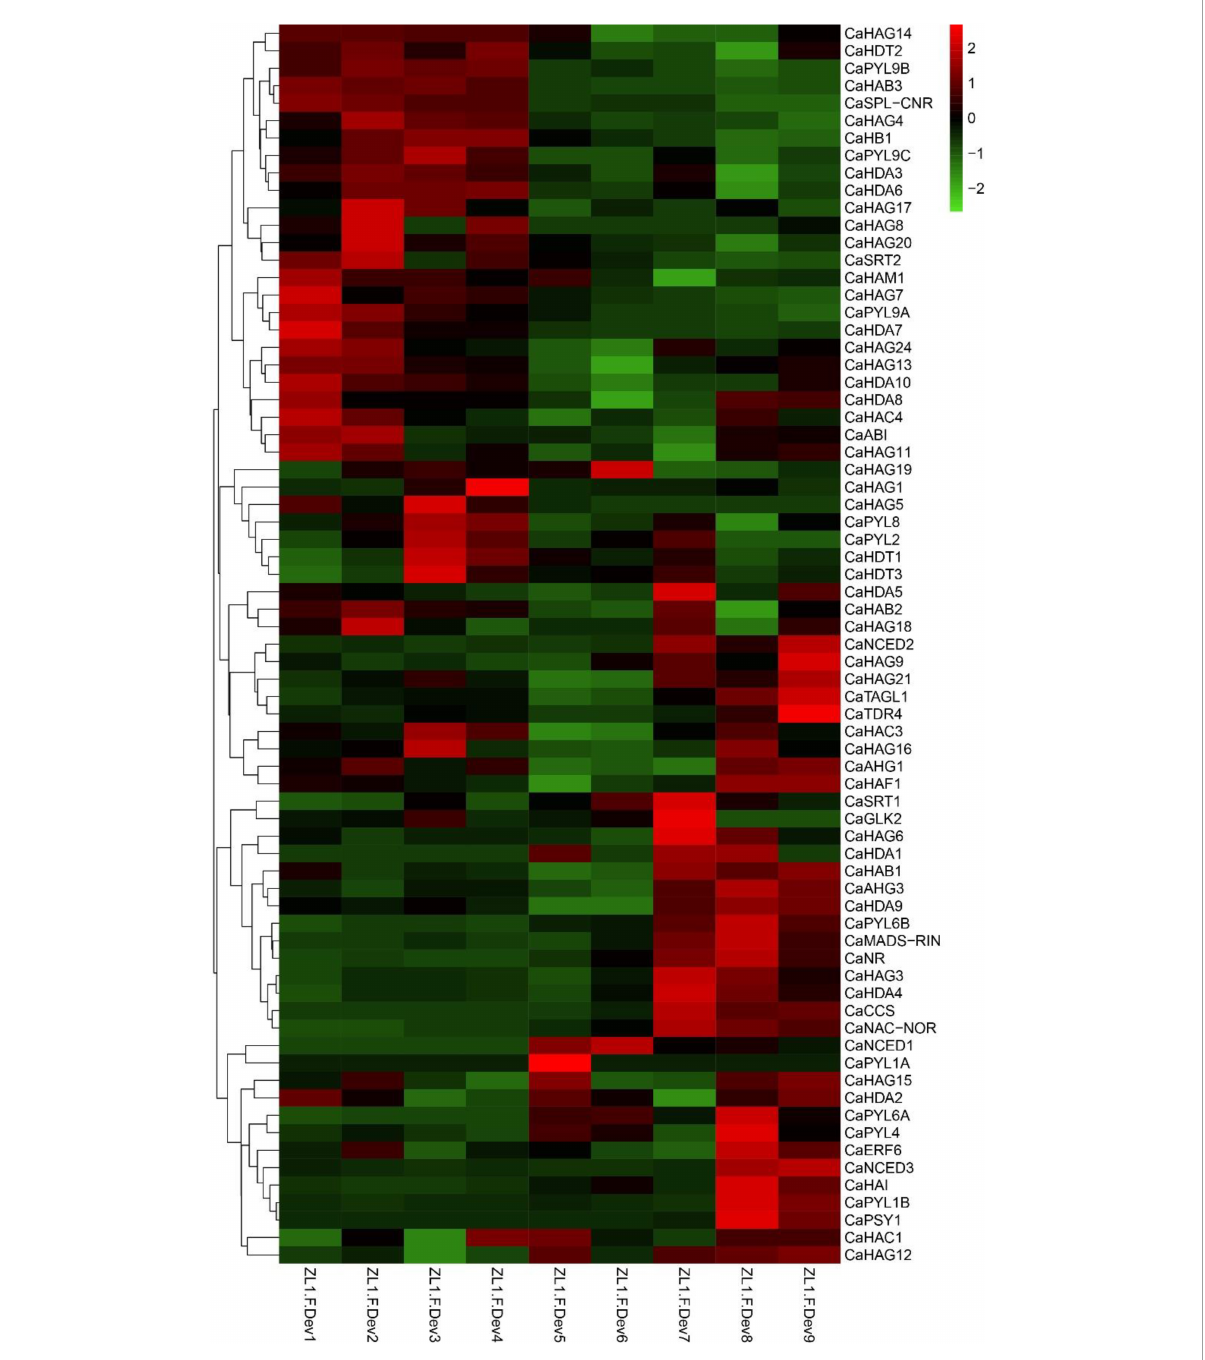
FIGURE6 Expression profiles of CaHATs , CaHDACs, and ABA-related, ripening-related genes, and carotenoid biosynthetic genes. The ABA-related includes ABA biosynthetic ( CaNCEDs ) and signaling transduction genes ( CaPYLs ). Carotenoid biosynthetic genes include CaPSY1 and CaCCS . The ripening-related genes were different transcription factors that govern the ripening